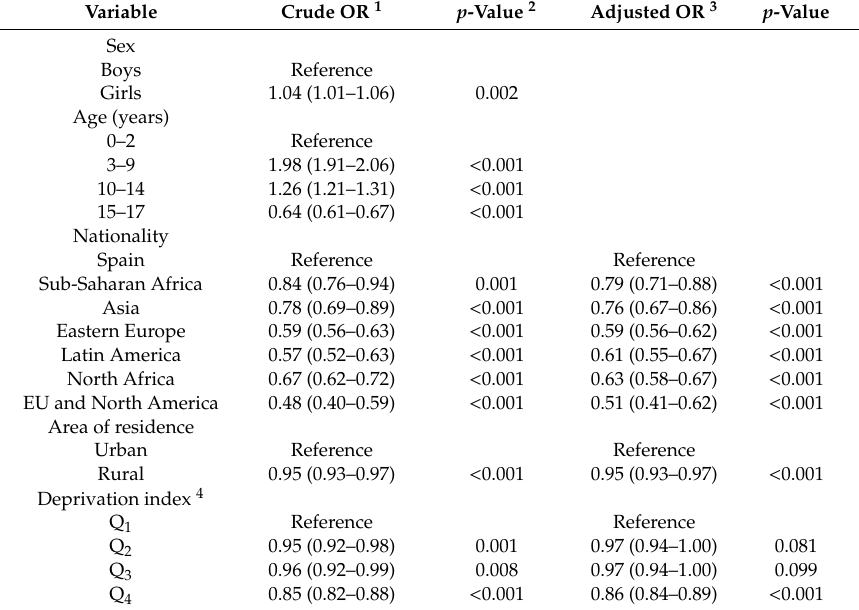
Table 2. Likelihood of presenting atopic dermatitis based on sex, age, nationality, area of residence (urban / rural), and deprivation index of the area, calculated using logistic regression